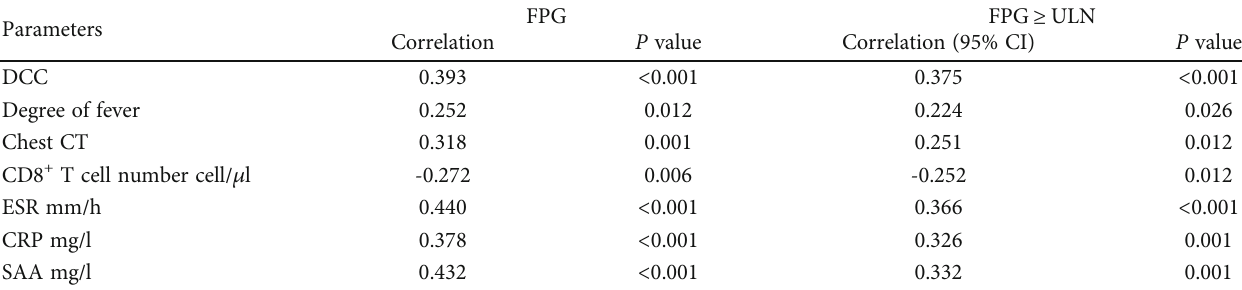
Table 5: Spearman ’ s correlation between FPG and other